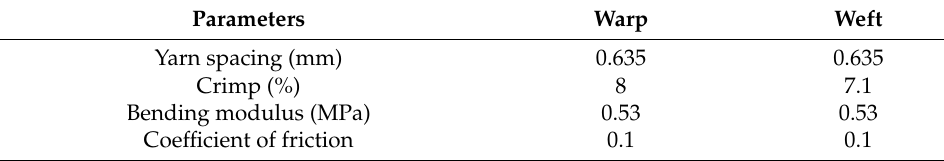
Table 2. Fabric Parameters.